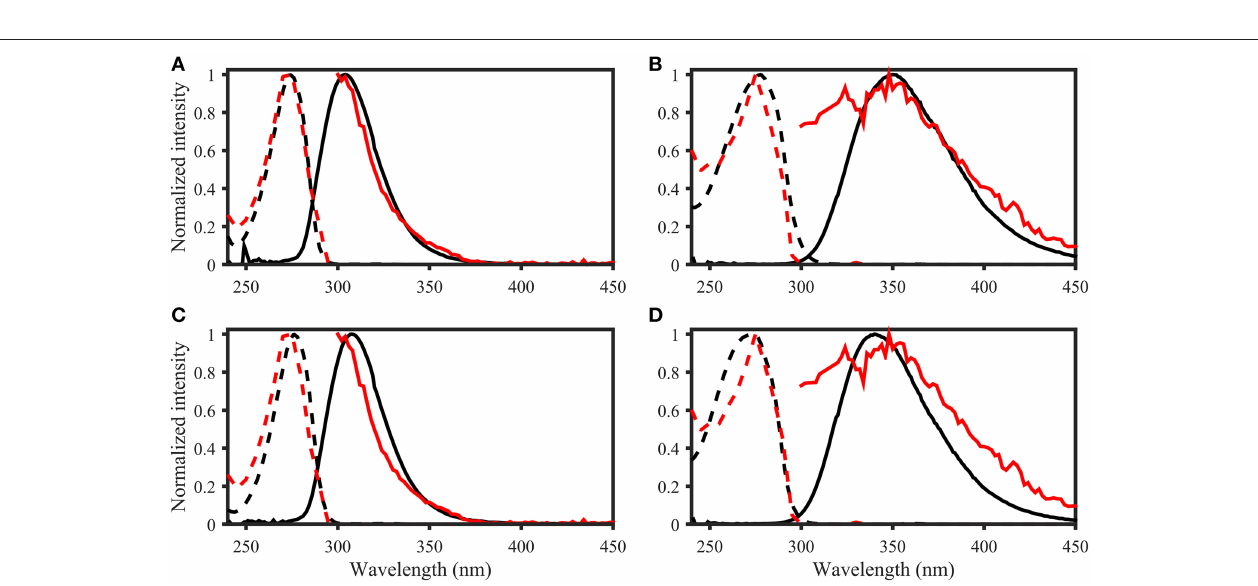
FIGURE 7 | Examples of spectral matching between PARAFAC components in the OpenFluor database with organic compounds. Dashed lines represent excitation loadings, solid lines show emission loadings. Organic compounds are shown in black, PARAFAC components in red. (A) Salicylic acid against component 5 from Kowalczuk et al. (2013), (B) Indole against component 3 from Kowalczuk et al. (2013), (C) p-cresol against component 3 from Murphy et al. (2011), (D) Coumarin against component 2 from Søndergaard et al. (2003).